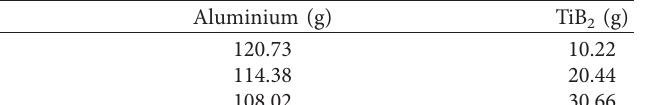
Figure 3: Processing methodology. Table 2: Sample preparation.